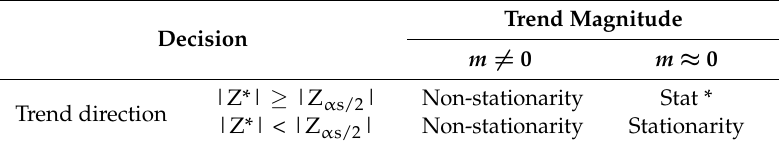
Table 2. Decision on whether to consider non-stationarity for frequency